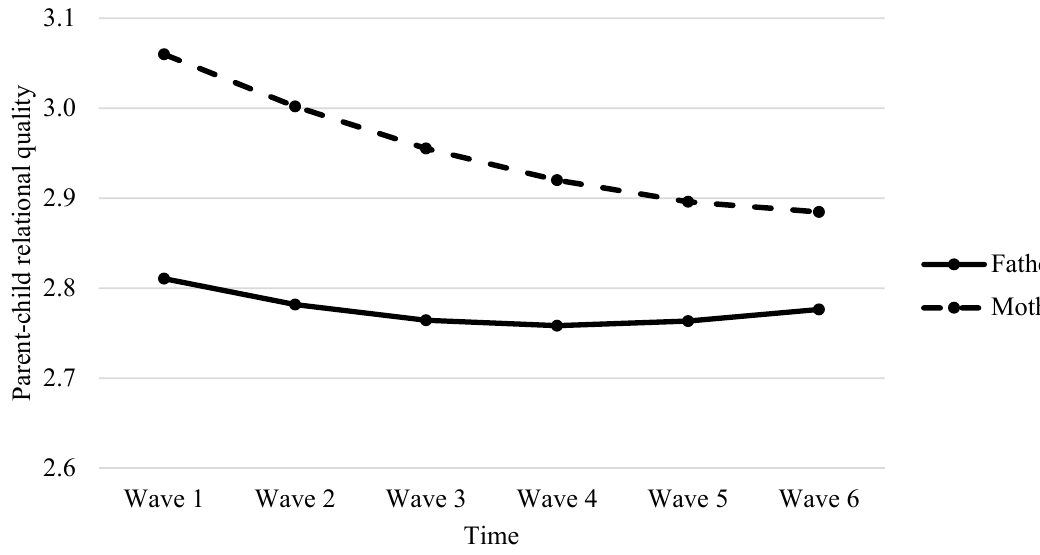
Figure 2. Fitted trajectories of parent-child relational quality of mothers and fathers. The figures were plotted based on Model 4c shown in Table 6.